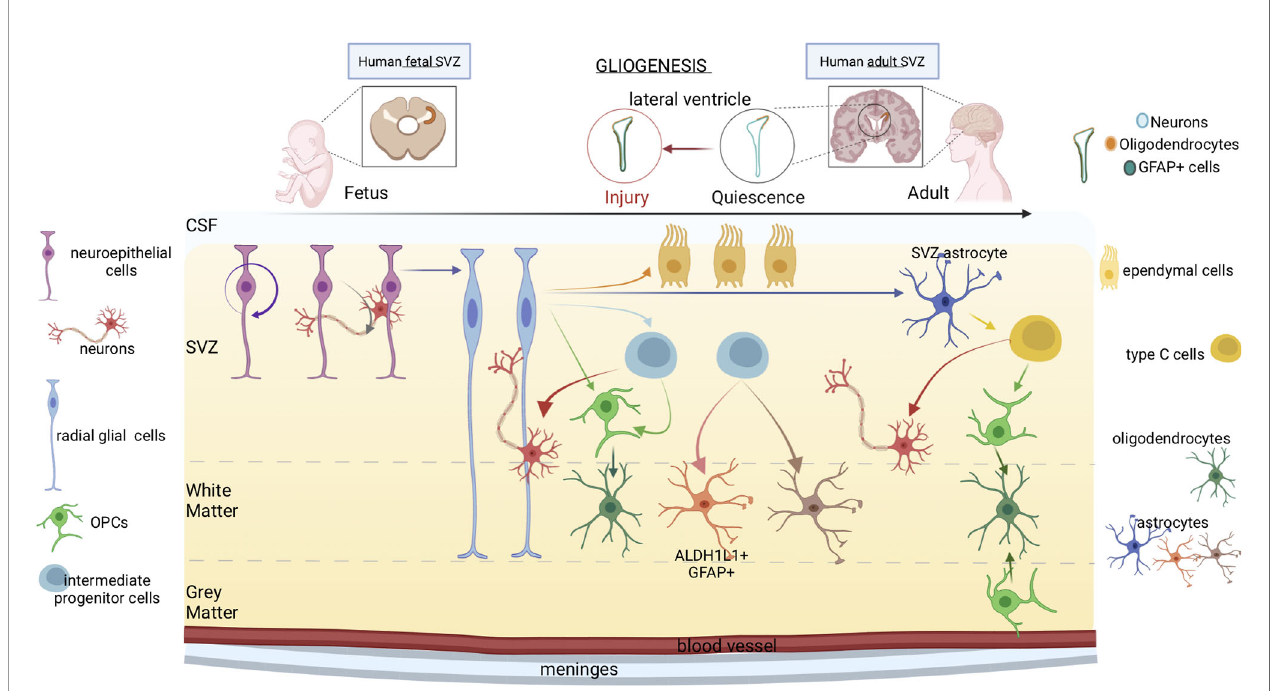
FIGURE 2 | Gliogenesis in human fetal and adult brain. The progression from fetal to adult gliogenesis in the SVZ, which lines the lateral and septal sides of the lateral ventricle (LV), is shown. Arrows indicate cellular self-renewal or differentiation. Neuroepithelial stem cells, which can generate neurons, border the ventricles throughout the neuraxis at the stages of neural tube closure. At the beginning of the neurogenesis, neuroepithelial cells differentiate into radial glial cells. Radial glia produces intermediate progenitor cells and OPCs, which further differentiate respectively into neurons and oligodendrocytes. Radial glial cells have also the capacity to become astrocytes or produce intermediate progenitors. Lastly, intermediate progenitor cells can generate different subtypes of astrocytes. In adults, neural stem cells are neurogenic, yet, under some conditions like in response to injury, gliogenesis generate reactive astrocytes and oligodendrocyte-lineage cells. Oligodendrocytes are produced by either type C cells or OPCs located in the grey matter. Type C cells produce OPCs as well as neurons. The OPCs subsequently differentiate into